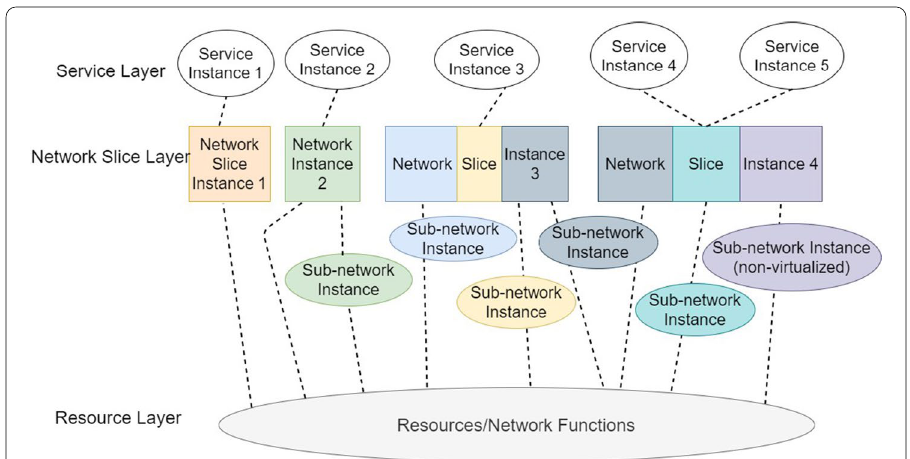
Fig. 5 Network slicing model in a layered